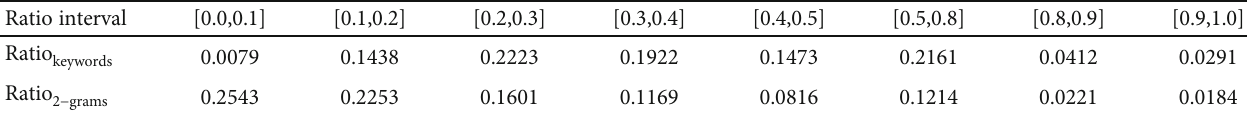
Table 3: Rational distribution of score interval of keywords and 2-grams. Ratio